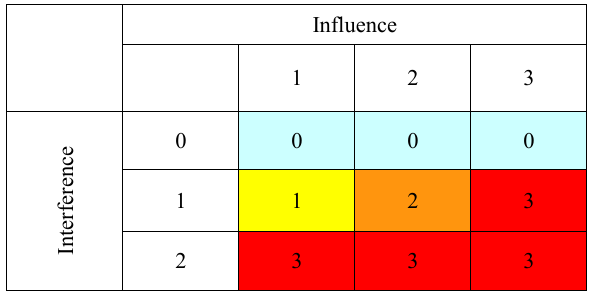
Table 1. Matrix of pressure